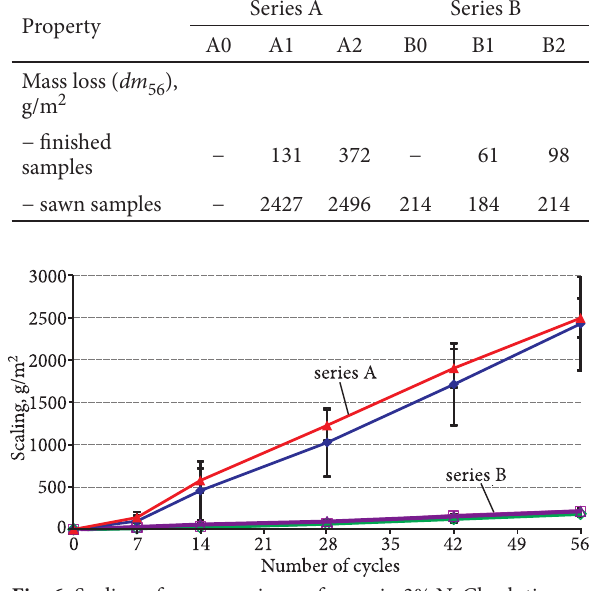
Fig. 6. Scaling of sawn specimens frozen in 3% NaCl